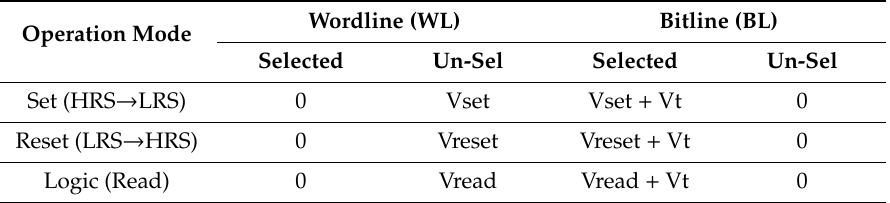
resistance state; LRS—low-resistance